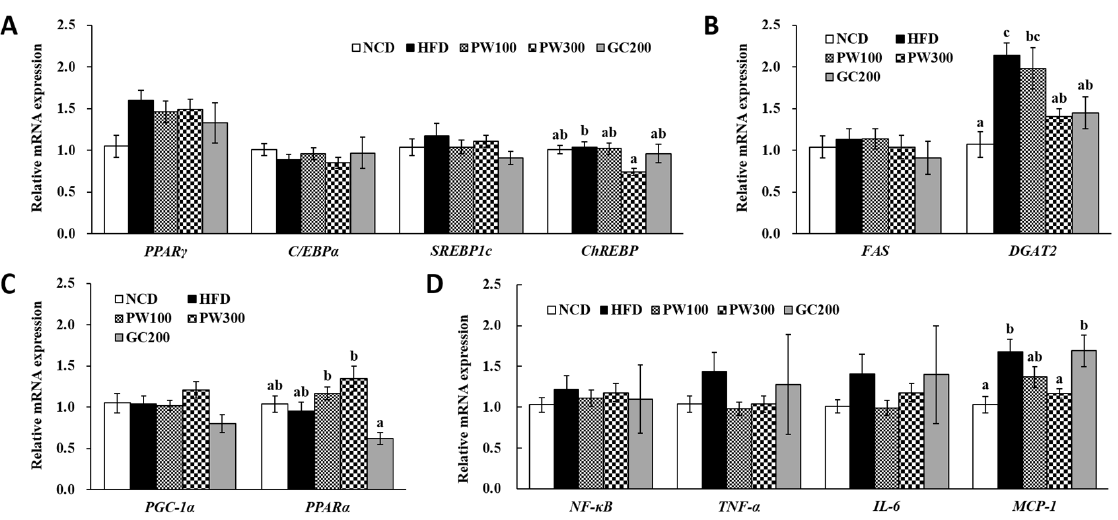
Figure 2. Effects of Polygonum multiflorum Thunb. hot water extract on adipogenic and lipogenic transcriptional factor ( A ), lipogenic genes ( B ), FA oxidative transcriptional factor ( C ), and inflammatory gene ( D ) expressions of epididymal WAT in HFD-induced obese mice. Data are expressed as means ± SE. Values with different superscript letters are significantly different at p < 0.05 as determined by one-way ANOVA followed by Tukey’s HSD test.